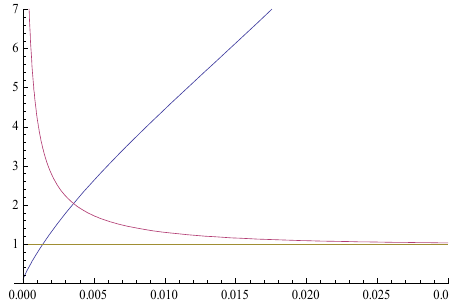
Figure 1. Model of behavior of the functions a ( t ) and S β ( t ) at small values of time t